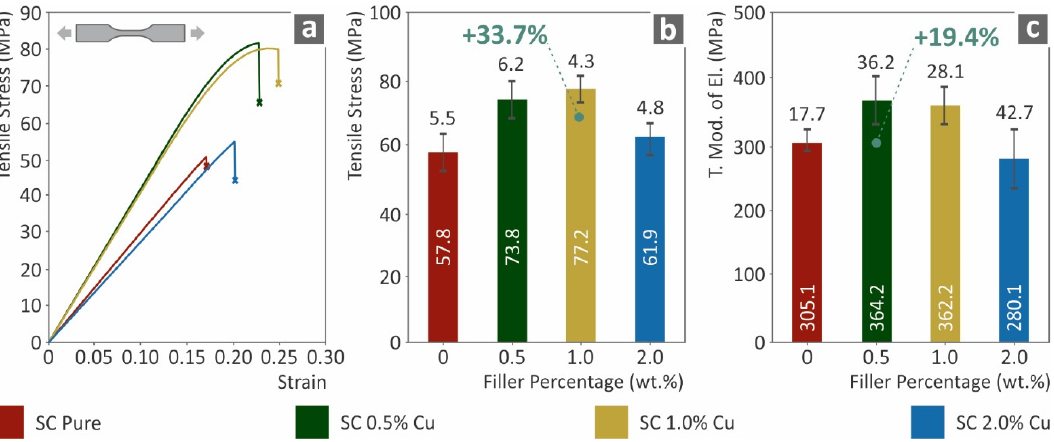
Figure 3. ( a ) Typical tensile stress (MPa) to strain (mm/mm) curves, ( b ) tensile stress at break (MPa) to filler loading (wt.%), ( c ) tensile elastic modulus (MPa) to filler ratio (wt.%).